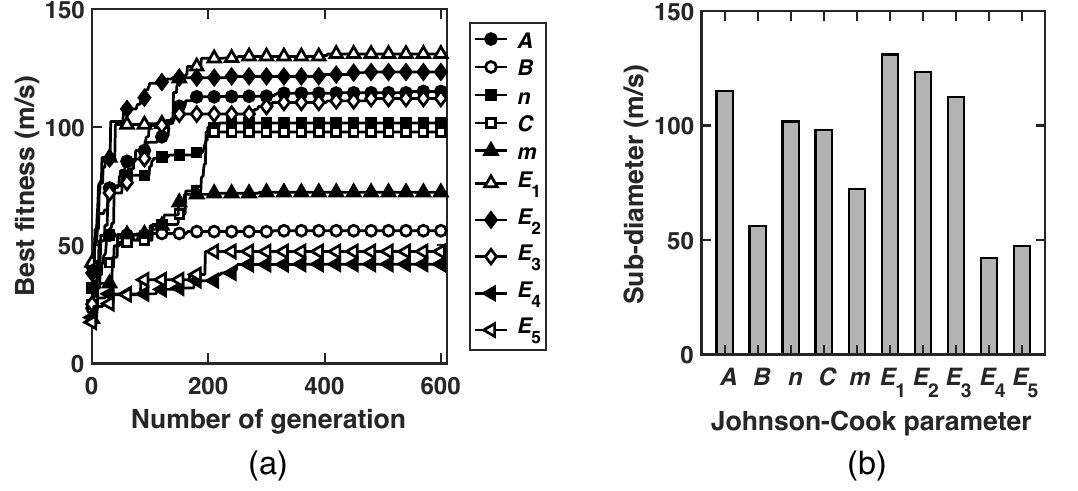
Figure 4. Uncertainty quantification for the ballistic problem. ( a ) History of the best fitness in GA cal- culations. ( b ) Sub-diameters of random parameters in Johnson–Cook plasticity and fracture